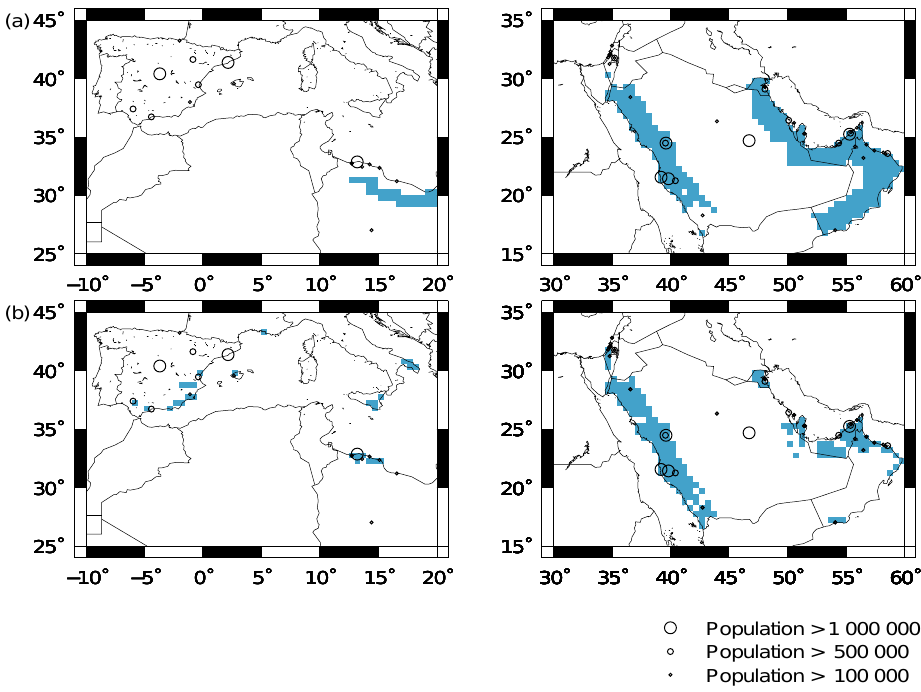
Figure 4. Simulated distribution of area utilizing seawater desalination (AUSD) in the Mediterranean and Middle East in 2005. (a) Results from SDM, (b) results from AUXSDM (see Sect. 3.2). Circles represent major cities (GeoNames).